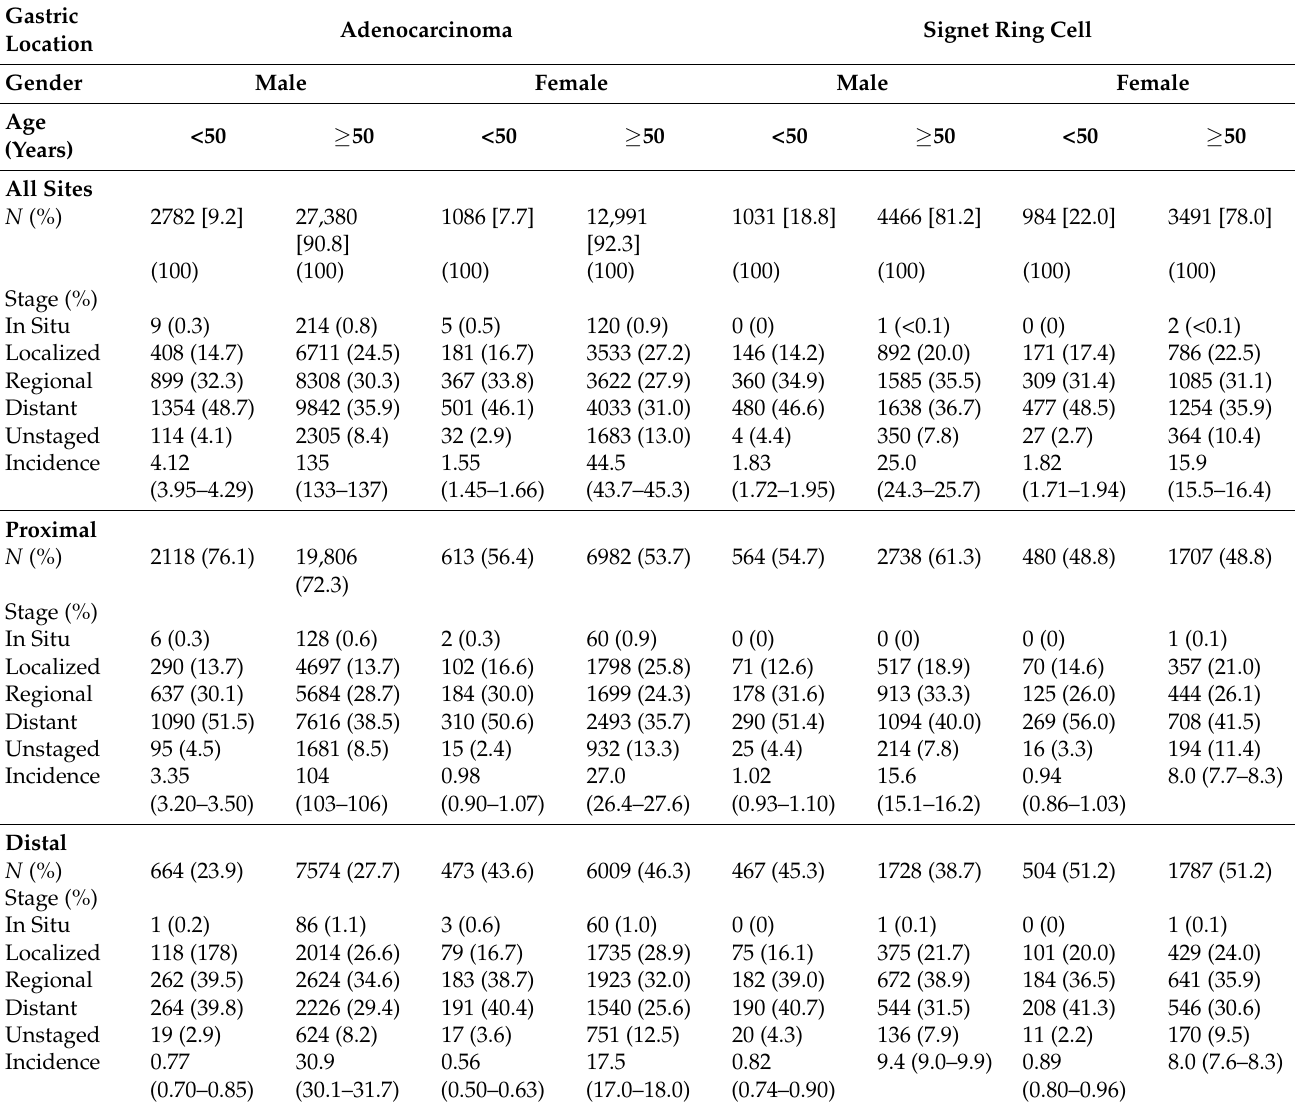
Table 2. Distribution of gastric cancer by localization, dichotomized by sex, and age